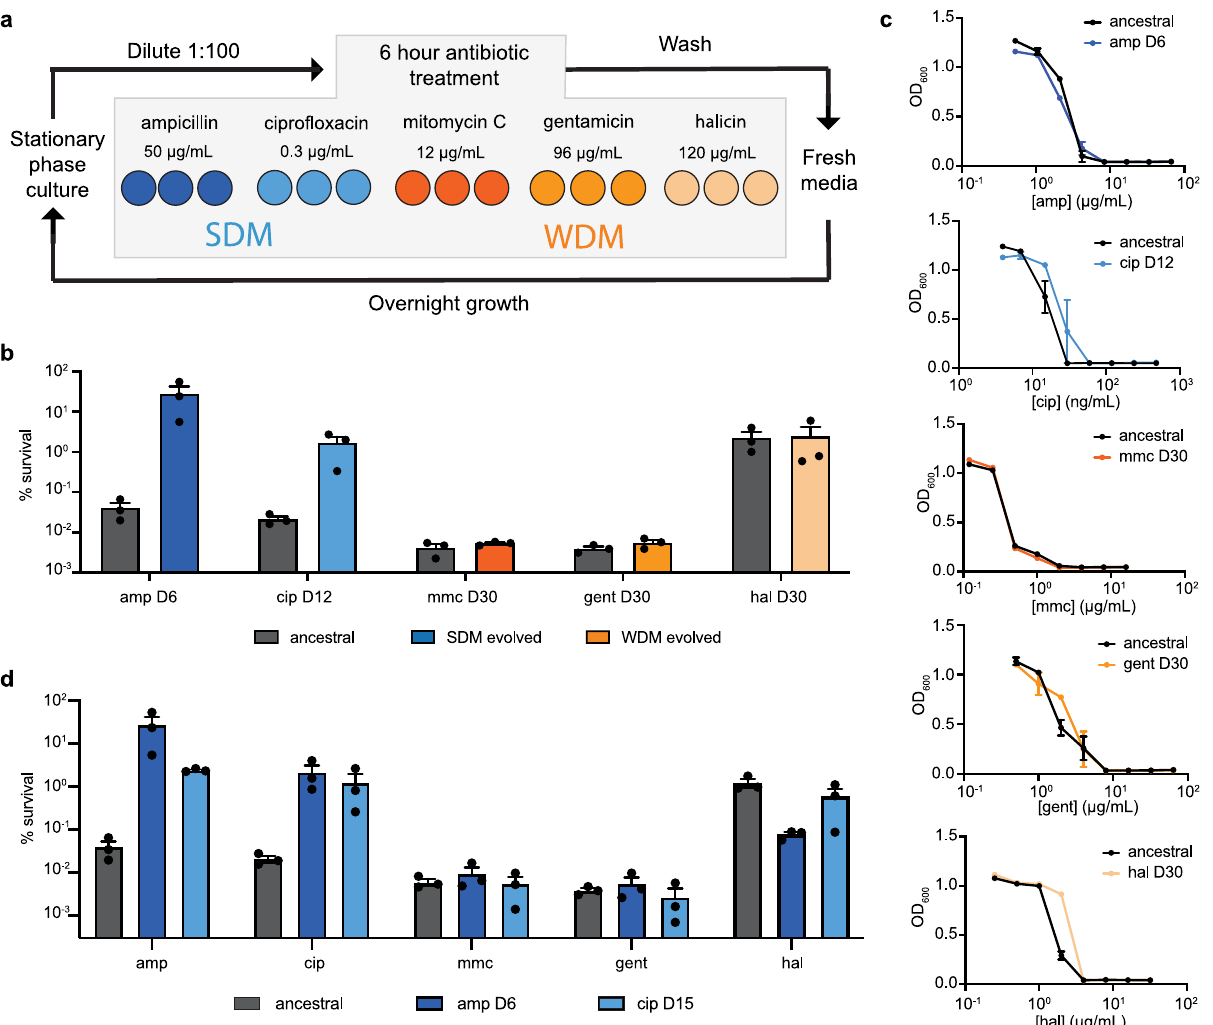
Fig. 1 Tolerance evolves during repeated SDM but not WDM antibiotic treatment. a Schematic of evolution. An overnight culture of E. coli BW25113 was diluted 1:100 in LB, then incubated with an SDM or WDM antibiotic at the indicated concentration for 6 hours in a deep 96-well plate in triplicate. Next, plates were centrifuged and washed two times in PBS. Cells were then re-suspended in fresh LB, grown overnight, and the process was repeated the following day. b Percent survival of ancestral and evolved cells against SDM and WDM antibiotics. Horizontal axis labels indicate the antibiotic on which the culture was evolved and the evolution day (i.e., amp D6 indicates cells were evolved on ampicillin for 6 days). Data are representative of three biological replicates; error bars show SEM. c MICs of ancestral and evolved cultures. Experiments were performed in biological triplicate; error bars indicate SEM. d Cross-tolerance of ampicillin- and cipro fl oxacin-evolved cultures. Horizontal axis labels indicate the antibiotic tested for cross-tolerance. The fi gure legend indicates the antibiotic on which the culture was evolved and the evolution day. Shown is the mean of three biological replicates; error bars indicate SEM. Source data are provided as a Source Data fi